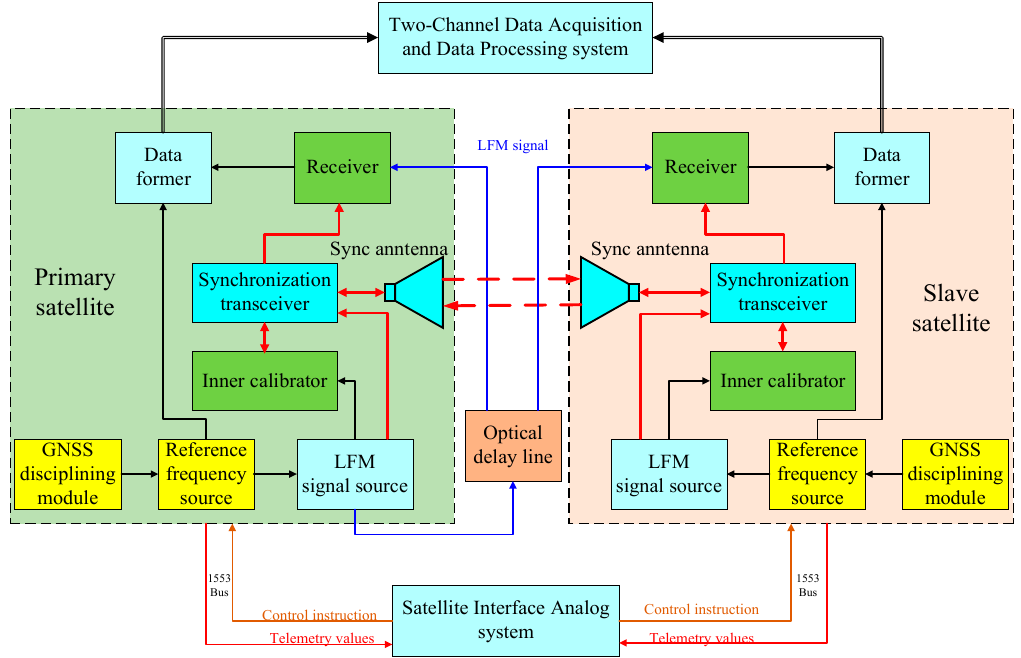
Figure 5. The structure block diagram of the ground test system.